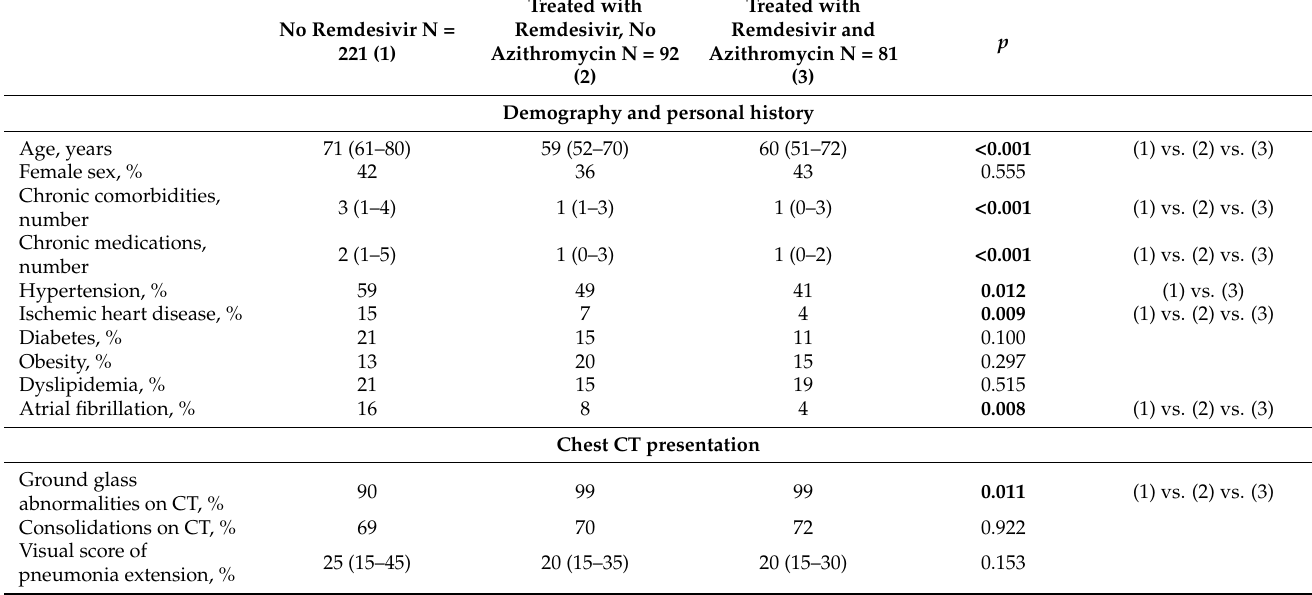
Table 2. Comparison of the main characteristics of patients who were not treated with remdesivir